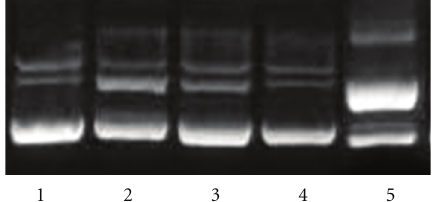
Figure 3: DNA hydrolysis by single-chain antibodies BV04-01, MRL-4 and their mutants. Supercoiled plasmid substrate was incubated overnight with 0.1mkg of di ff erent ScFv in bu ff er, containing 20mM Tris-HCl pH 7.5, 100 mM NaCl, and 1mM MgCl 2 . Lane 1: control plasmid without an antibody; lane 2: plasmid with ScFv mutant BV04-01 VH A23P; lane 3: plasmid with ScFv mutant MRL-4 VH P23A; lane 4: plasmid with ScFv MRL-4; lane 5: plasmid with ScFv